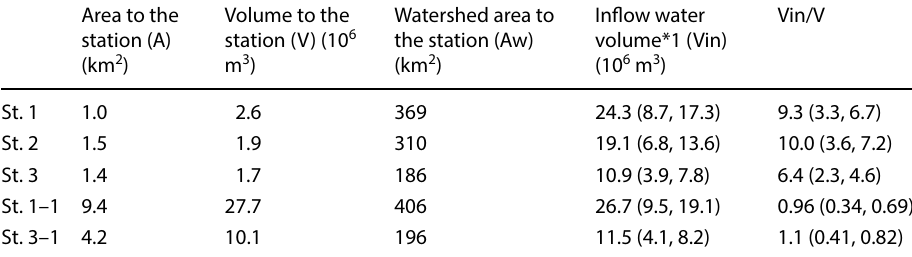
Table 1 Water volumes to the targeted stations and inflow water volumes caused by extreme rainfall events (EREs) and large rainfall events